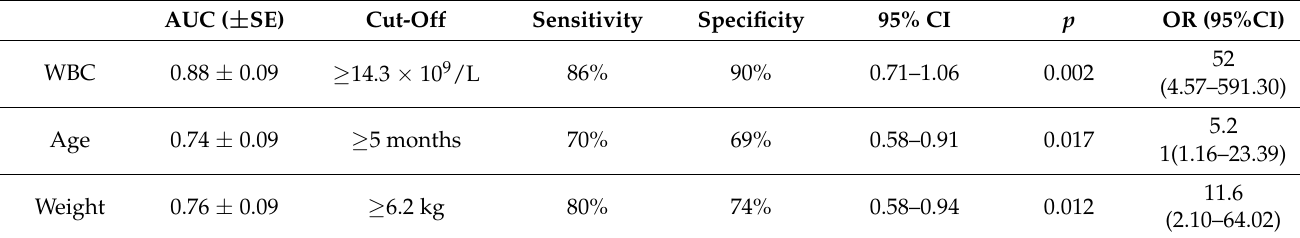
Table 3. ROC-curve data of selected variables and their cut-off values indicative of complicated disease course regarding urachal